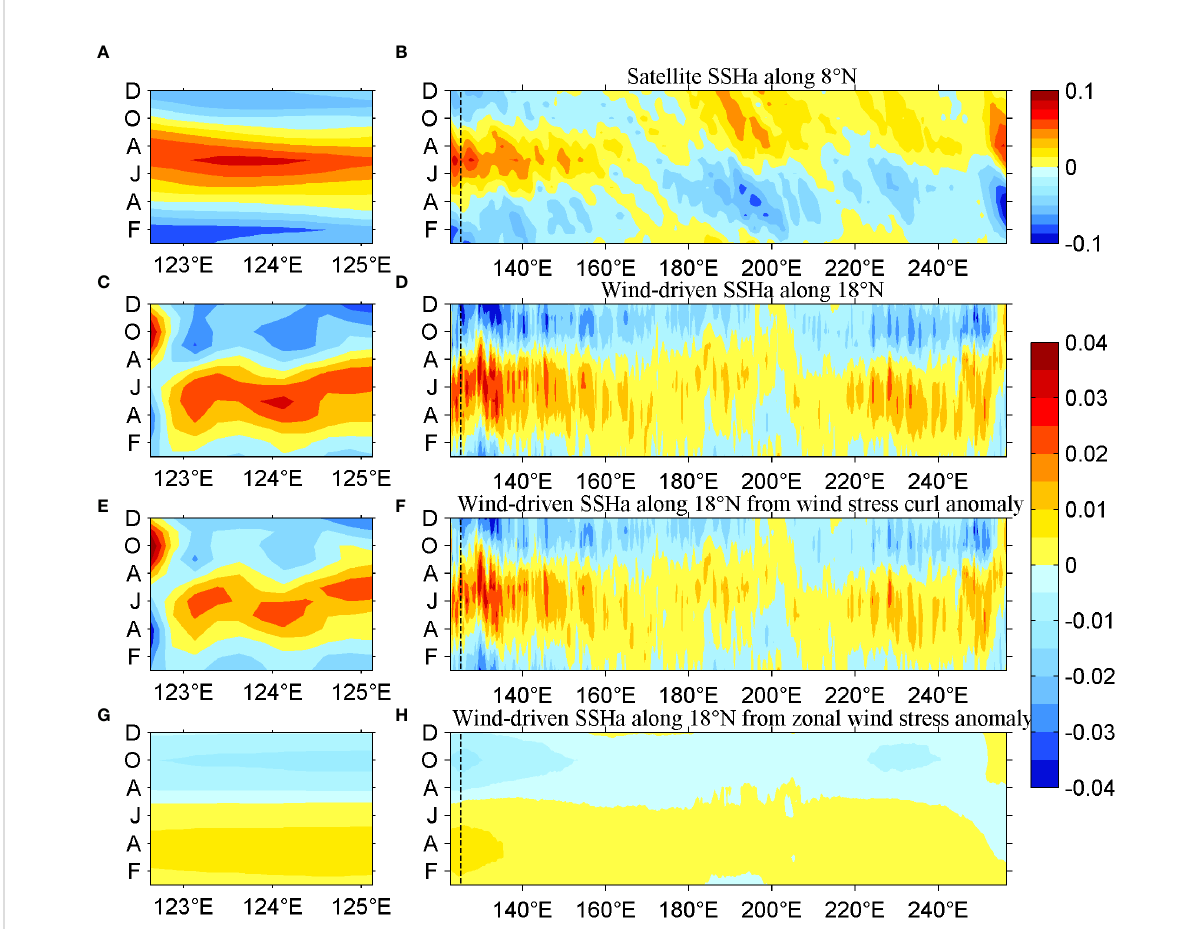
FIGURE 12 Longitude – time diagrams of seasonal SSHa along 18°N from satellite data (1993 – 2019) (A) along the western boundary and (B) in the North Paci fi c Ocean. Diagrams of wind-driven SSHa along 18°N based on QuikSCAT products (1999 – 2009) calculated from Eq. (4) (C) along the western boundary and (D) in the North Paci fi c Ocean. Diagrams of wind-driven SSHa along 18°N based on QuikSCAT products (1999 – 2009) forced by wind stress curl anomaly (E) along the western boundary and (F) in the North Paci fi c Ocean, and by zonal wind stress anomaly (G) along the western boundary and (H) in the North Paci fi c Ocean. (Units are